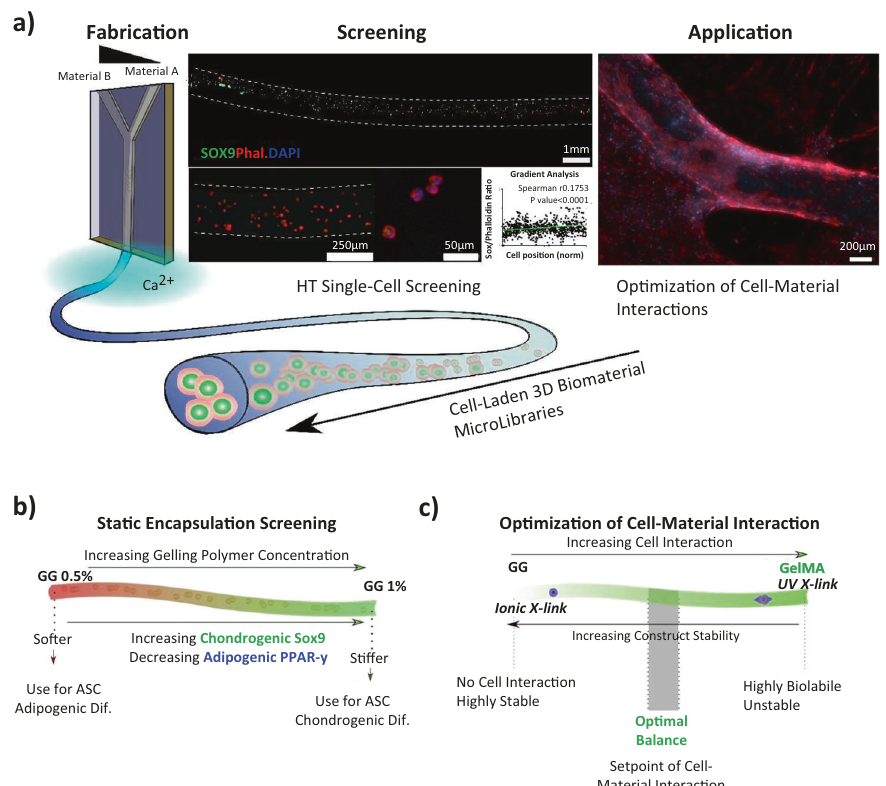
Fig. 3 A fully high-throughput (HT) micro fl uidic platform for the generation of novel multi-material, multi cross-linking 3D cell-laden gradients as screening libraries ( a ). This high-throughput can be used to fabricate gradient libraries of polymer concentration to investigate the variable resultant cell phenotype to optimise material properties ( b ), or to optimise the cross-linking of materials and method of cross- linking to investigate cell – matrix interactions ( c ). Such a gradient platform allows for rapid screening of adhesion-related responses to determine material formulations for optimal function. In this study, cell-interactions were promoted with increasing UV cross-linking. Reproduced by permission of The Royal Society of Chemistry- Mater. Horizons (2020)